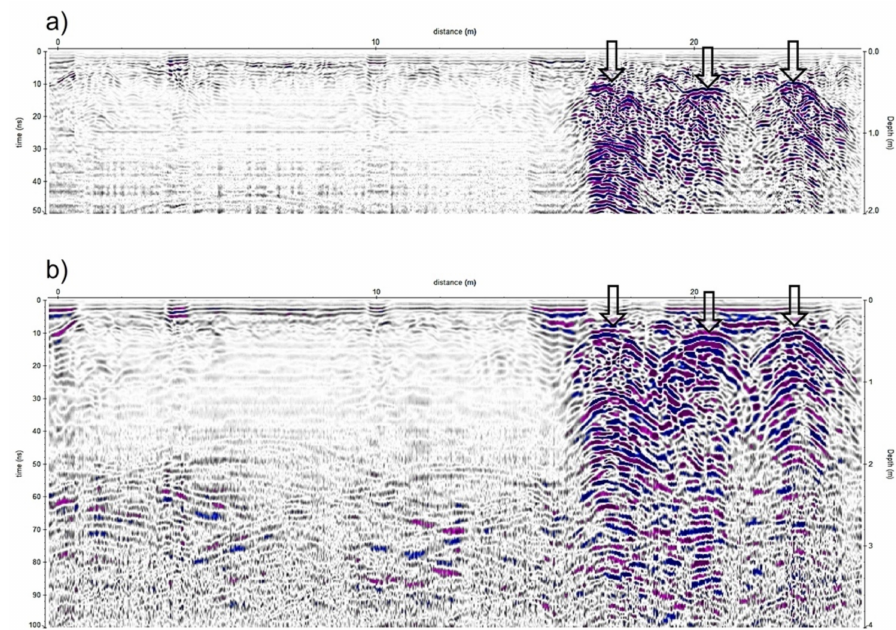
Figure 8. 2D GPR profiles, acquired with 600 MHz antenna ( a ) and 200 MHz antenna ( b ). Position of the profile is highlighted in red in Figure 6. The arrows show the position of hyperbola corresponding to the trapdoors in the